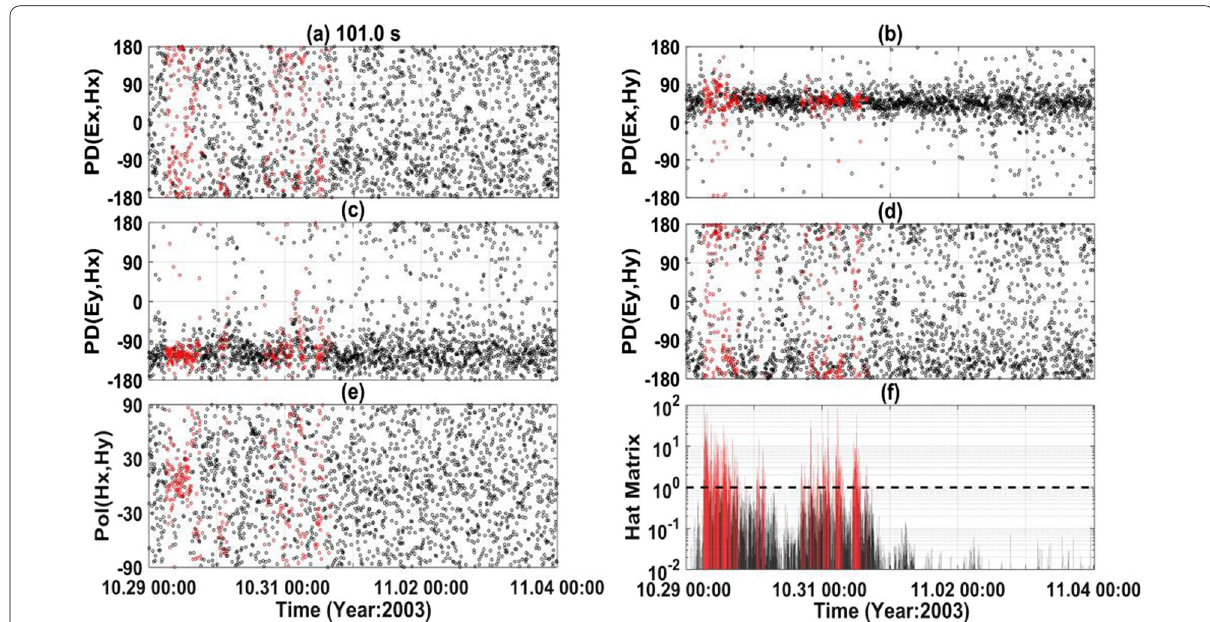
Fig. 5 Evaluation indices in the period of 101 s using the data observed at site 163 from 00:00 on October 29 to 00:00 on November 4. a – d Show the variation in PD ( E x , H x ), PD( E x , H y ), PD( E y , H x ) , and PD( E y , H y ) ; e shows the variation in polarization direction for the magnetic field; and panel (f) shows the variation in the normalized hat matrix’s diagonal element. The data in red correspond to the leverage point, whose hat matrix diagonal element exceeds the expected value (2/ N )